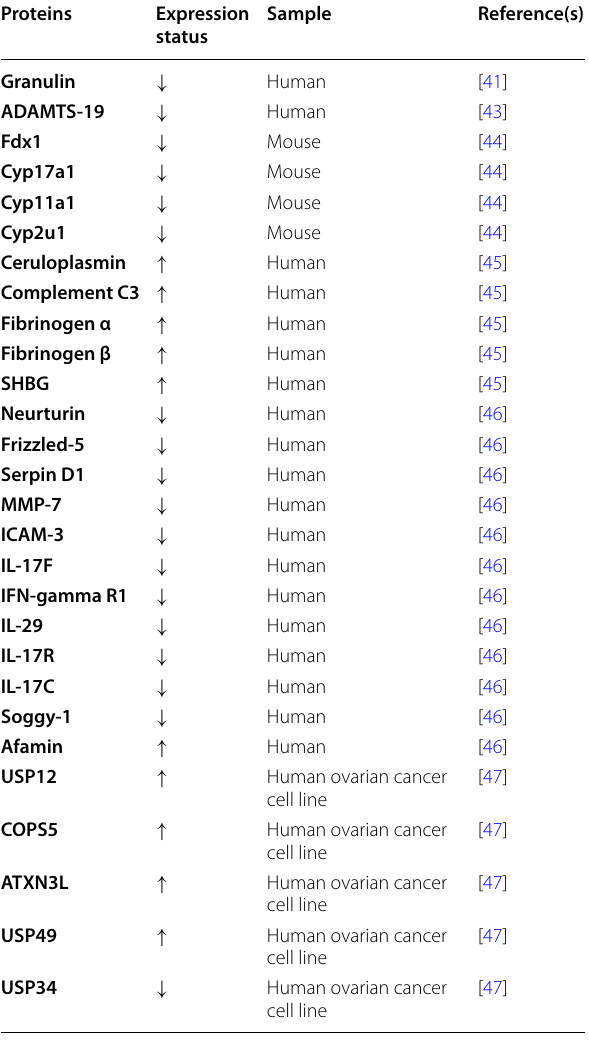
Table 1 List of potential protein biomarkers in